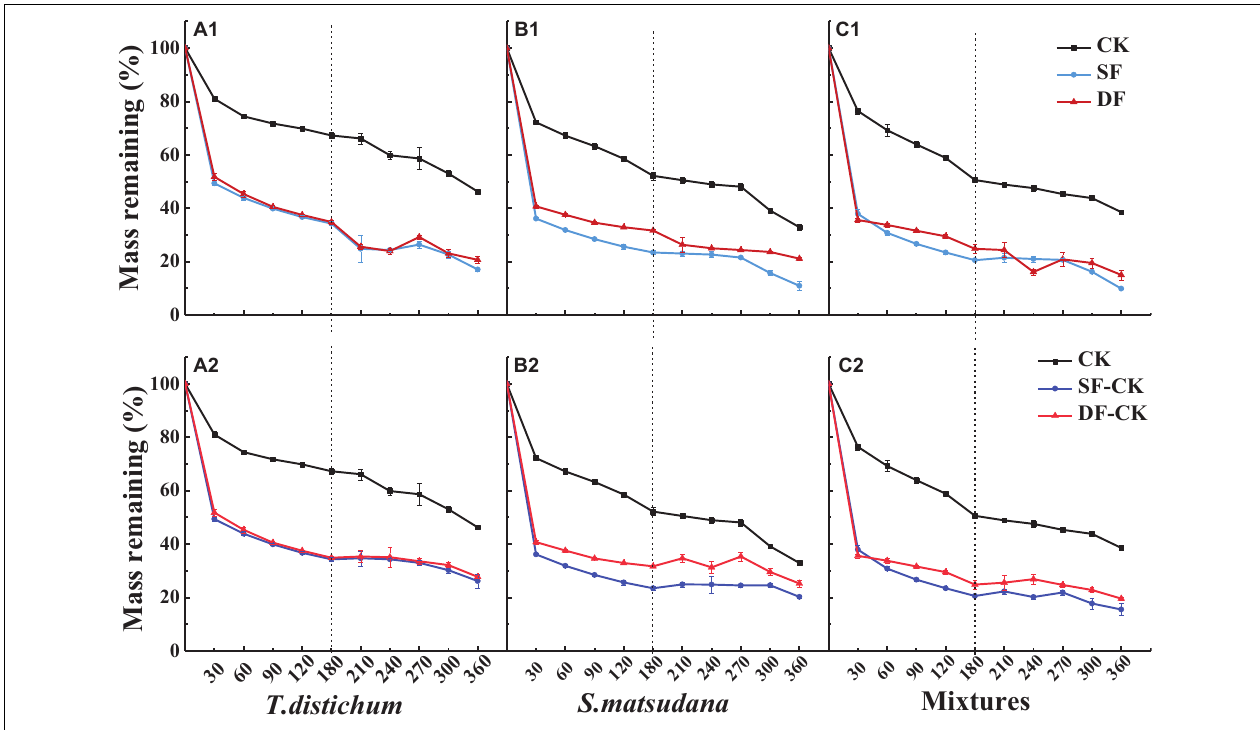
FIGURE 2 | The percentage of mass remaining of leaves of Taxodium distichum (A1,A2) , Salix matsudana (B1,B2) , and their mixtures (C1,C2) under different hydrological regimes during the decomposition. CK, unflooded; SF, shallow flooding; DF, deep flooding; SF-CK, first half a year SF followed by half a year CK; DF-CK, first half a year DF followed by half a year